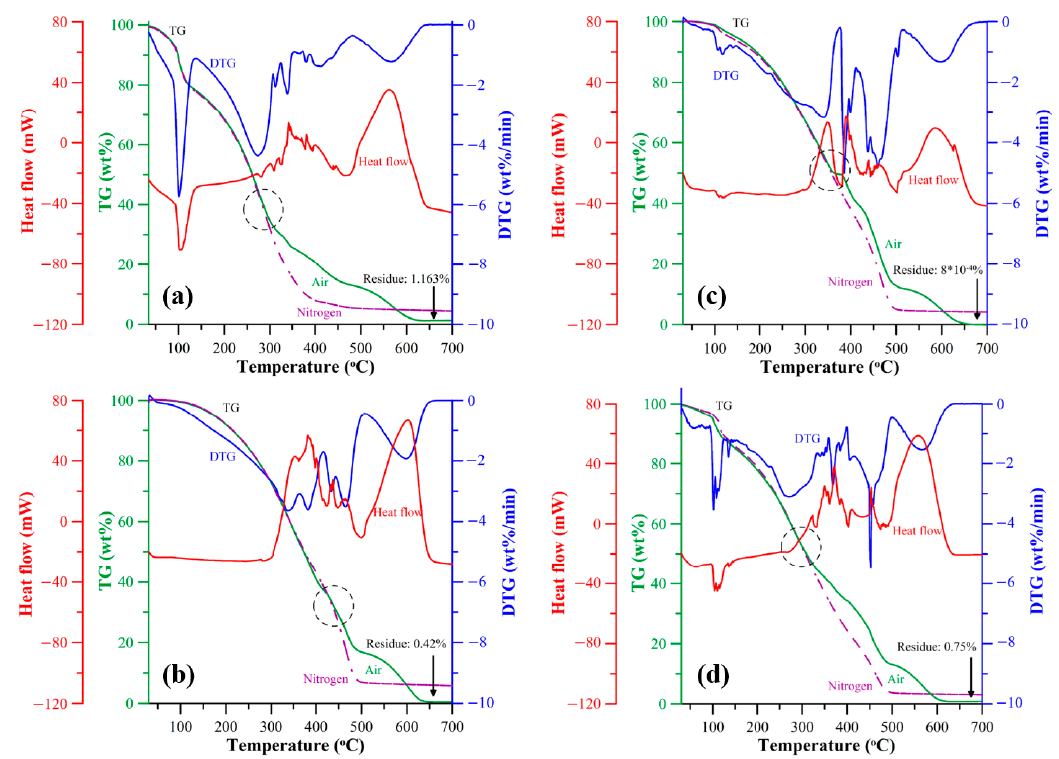
Figure 7. TGA burning profiles of sludge pyrolytic oil at a heating rate of 10 °C/min and air flow rate of 50 mL/min. ( a ) Pure sludge pyrolytic oil; ( b ) pure heavy fuel oil; ( c ) 20% sludge pyrolytic oil and 80% heavy fuel oil; ( d ) 50% sludge pyrolytic oil and 50% heavy fuel oil. (Green curve: TG; blue curve: DTG; red curve: DSC; purple curve: TG in the pyrolysis process).